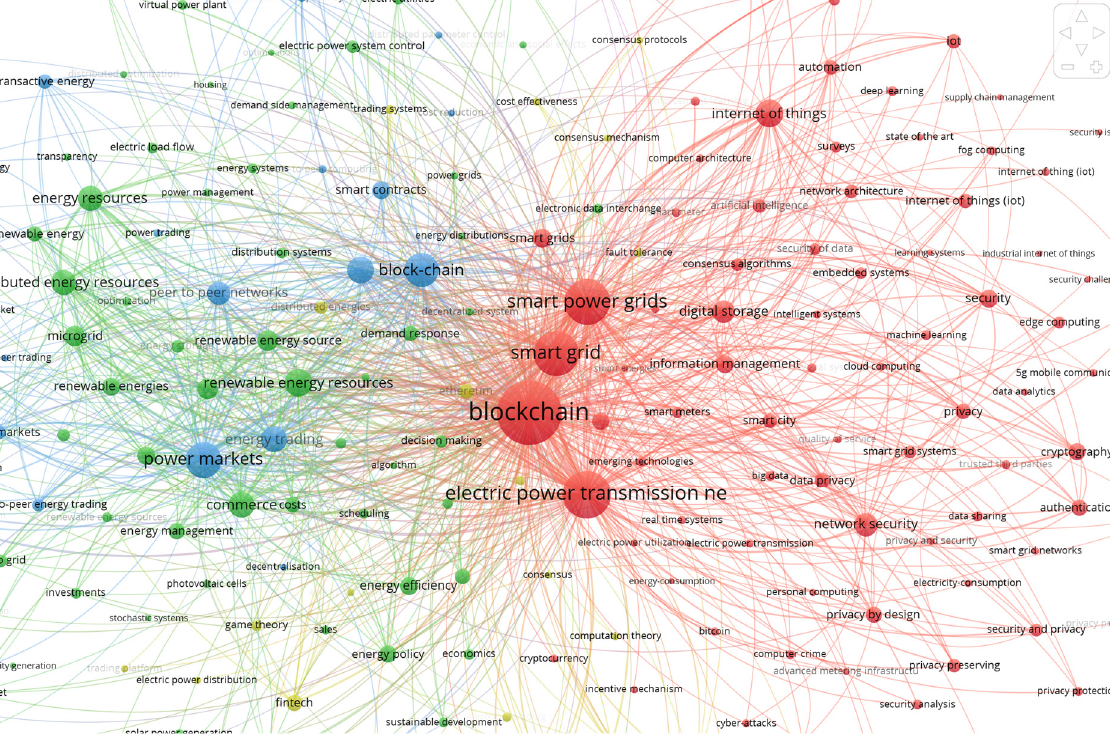
Figure A3. Keyword co-occurrence analysis (using VOS Viewer)—a time-based view.